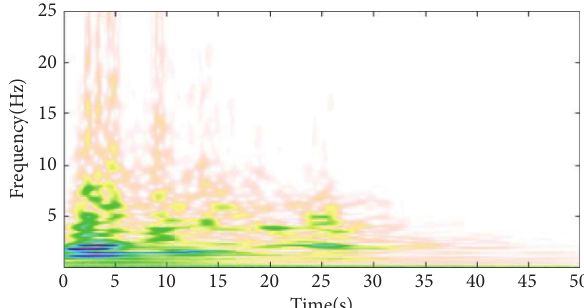
Figure 5: The energy distribution of input time-history on natural frequency-time plane.